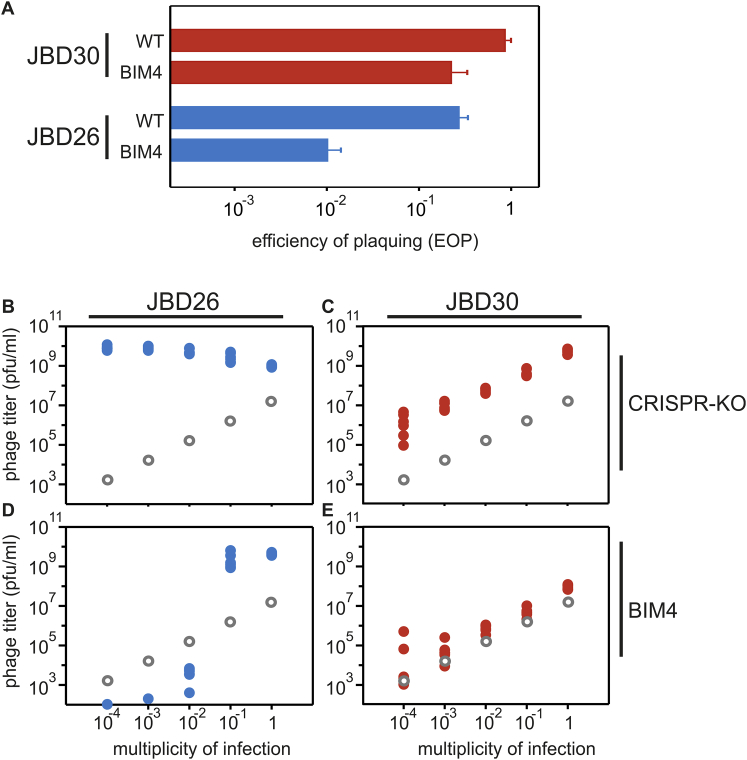
Bacteria with CRISPR Resistance Are Partially Immune to JBD26 and JBD30, Respectively, Related to Figure 1(A) Efficiency of plaquing (EOP) of JBD26, which encodes AcrIF4 (blue bars) and JBD30, which encodes AcrIF1 (red bars) on BIM4 (1 newly acquired spacer against both phages). Data correspond to the mean of 6 independent replicate experiments. Error bars represent 95% c.i.(B–E) Viral titers at 24 hours post-infection (hpi) with (B) JBD26 and (C) JBD30 on the CRISPR KO strain, (D) JBD26 and (E) JBD30 on BIM4. Gray circles indicate the phage titers (pfu/ml) at the start of the experiment (corresponding to the addition of 104, 105, 106, 107 or 108 pfus). Colored data points represent phage titers at 24 hpi. Note that the observed differences in amplification of JBD30 and JBD26 on CRISPR KO may be due to differences in their rates of lysogenisation. Each experiment was performed as 6 independent replicates, error bars represent 95% c.i.